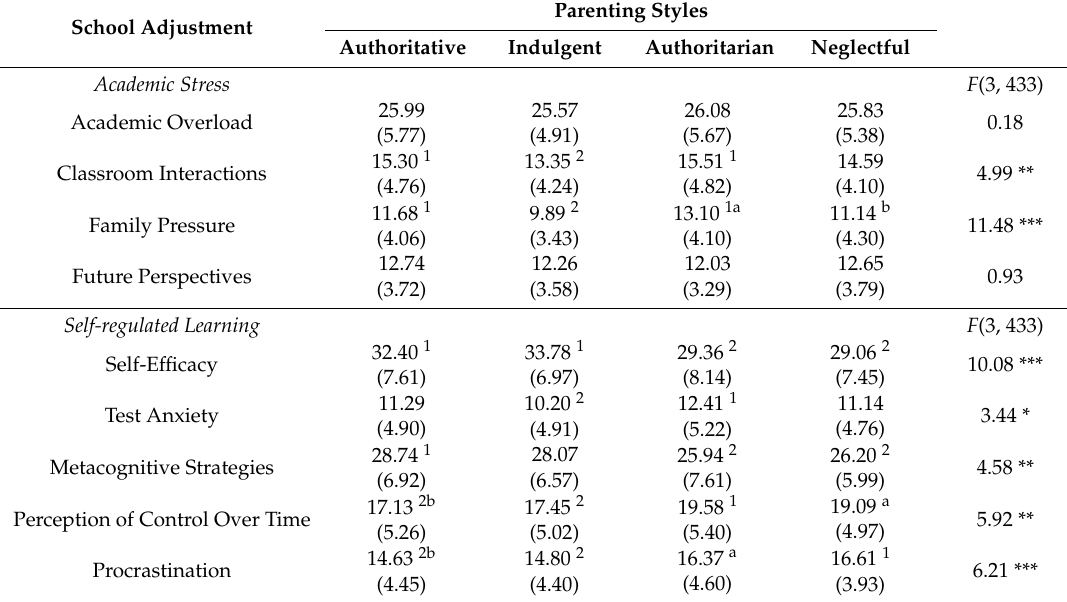
Table 2. Means, standard deviations (in parentheses), F values, and Bonferroni # test between parenting styles and stress and self-regulated learning